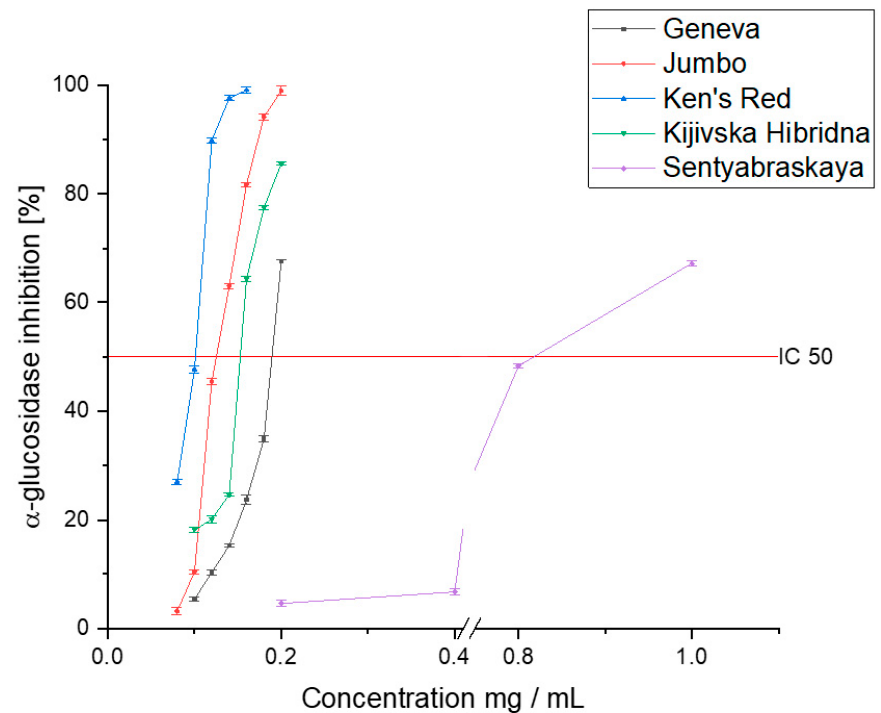
Figure 3. The ability of the tested cultivars to inhibit α -glucosidase.